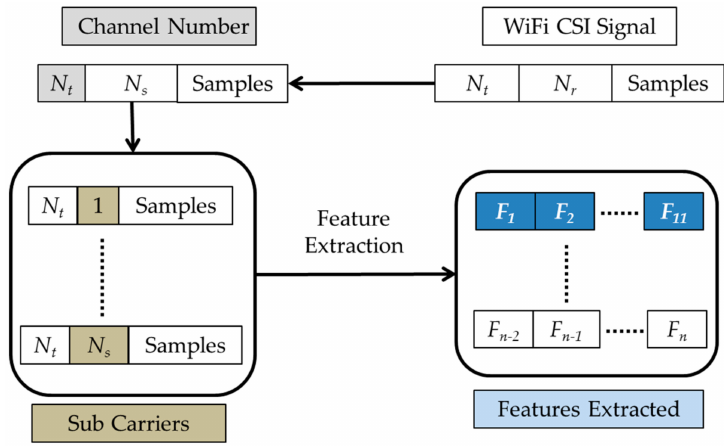
Figure 5. Feature